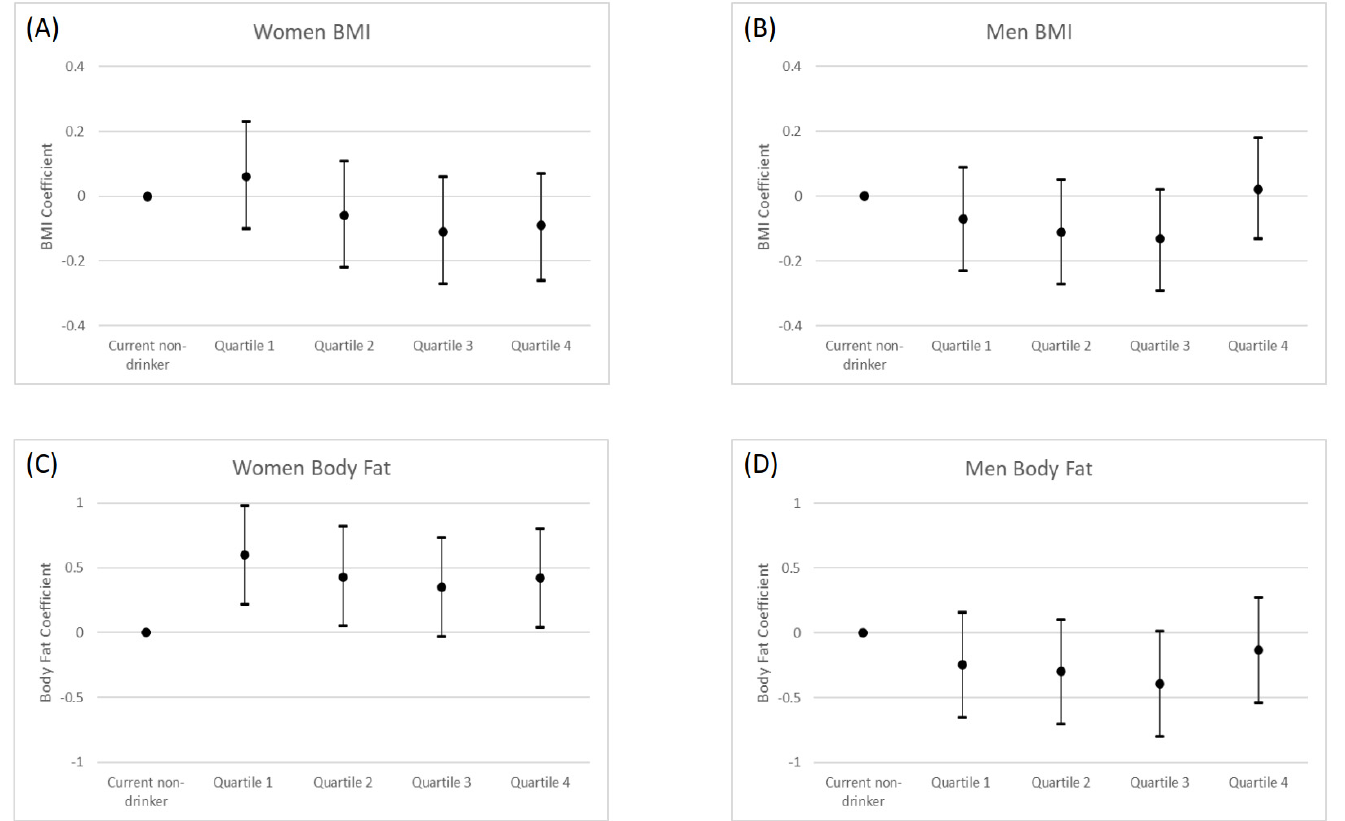
Figure 1. ( A – D ) Longitudinal associations between alcohol consumption and general adiposity by sex in the UK Biobank (Model 3). The coefficients were given in the Y -axis for each adiposity marker and display the mean difference between the reference category (current non-drinkers) and the other consumption categories. Model 3 is adjusted for baseline age, specific adiposity marker, follow up time (years), Townsend Deprivation Index, smoking status, major illness, sleep duration, PA, sitting time, daily vegetable and fruit consumption. Body mass index (BMI) = Weight (kg)/height (m 2 ). BF% was measured by bioimpedance using the Tanita BC-418MA device (Tanita, Tokyo, Japan). Alcohol consumption units by quartile: for women, 1st quartile: ≤ 1.3 unit; 2nd quartile: <6.9 unit; 3rd quartile: <14.3 unit; 4th quartile: ≥ 14.3 unit; for men, 1st quartile: ≤ 6.5 unit; 2nd quartile: <15.9 unit; 3rd quartile: <29.2 unit; 4th quartile: ≥ 29.2 unit.